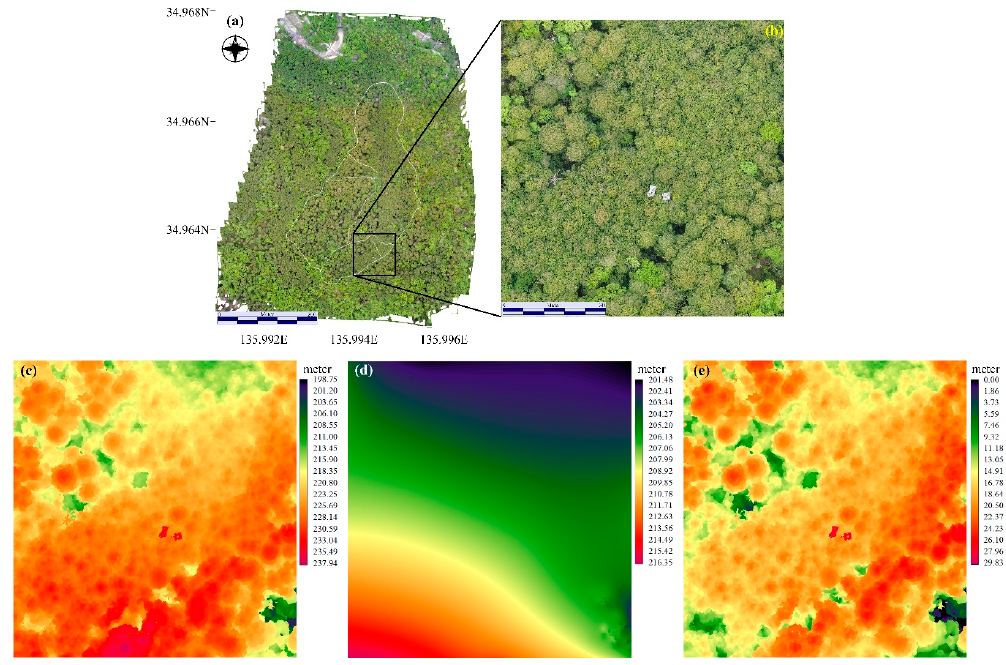
Figure 3. Graphical images of the ( a ) orthophoto; ( b ) area of focus within the study site; ( c ) digital surface model; ( d ) digital terrain model; and ( e ) canopy height model.